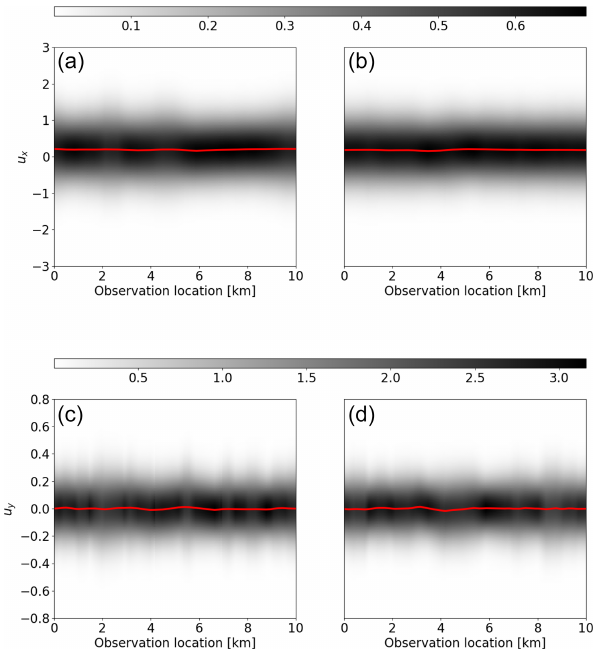
Figure 5. Second order statistics of the approximation errors for Example 1. (a, b) Distribution of the approximation errors in the x direction velocity measurements for Example 1a (a) and 1b (b) . (c, d) Distribution of the approximation errors in the y direction velocity measurements for Example 1a (c) and 1b (d) . The mean of the approximation errors, ε ∗ , is indicated with a red line, while higher probability density is indicated by darker shading.